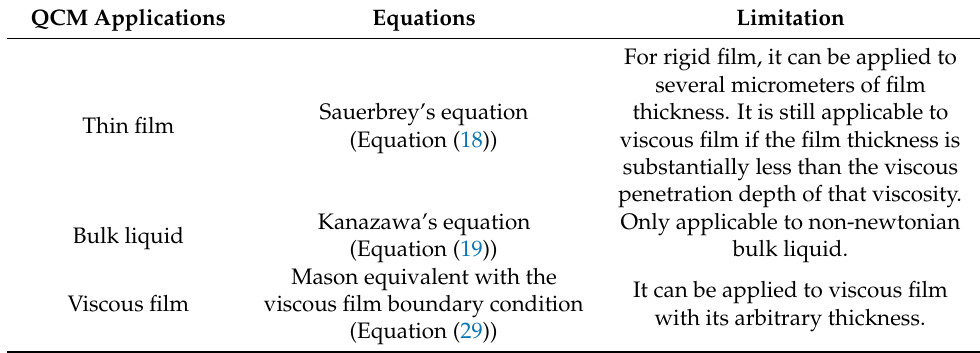
Table 2. General application guideline of QCM behavior